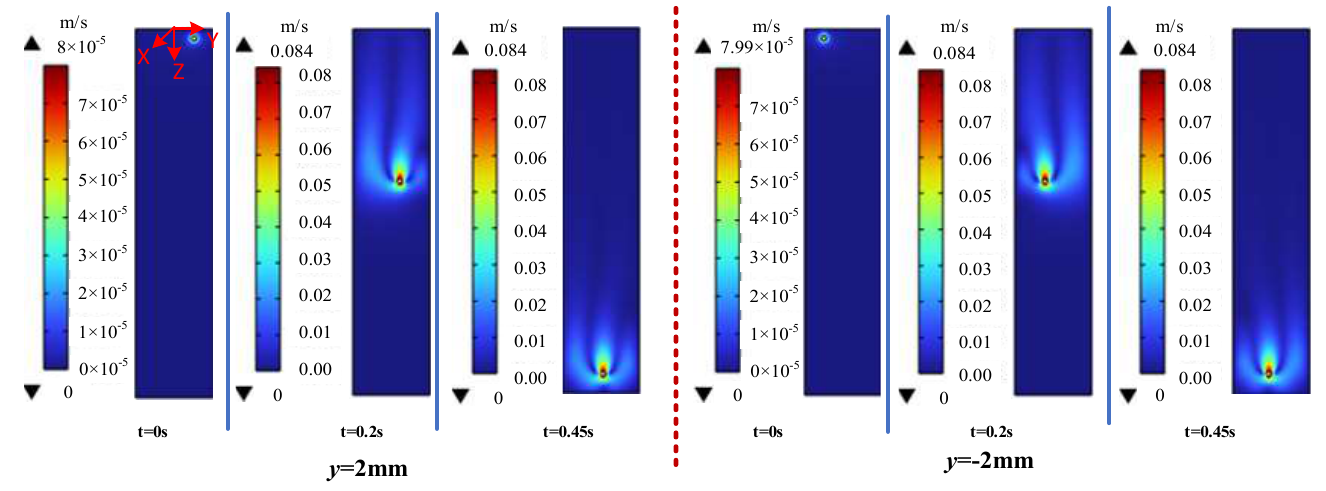
Figure 11. Velocities of 0.5 mm copper particle at different times after entering the pipeline from different positions ( y = 2 mm, y = −2 mm).